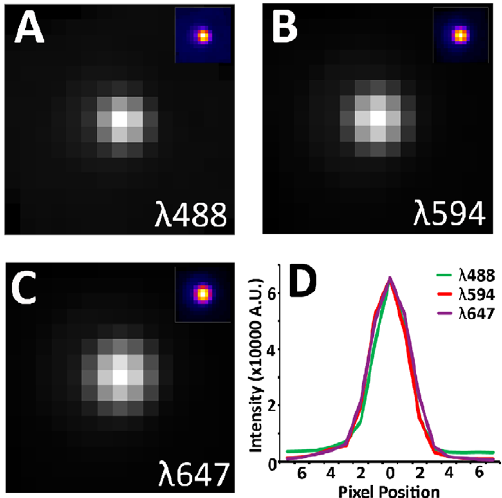
Figure 1. Empirically measure point spread functions (PSF). 110 nm Tetraspeck beads (Invitrogen) are suspended in ethanol. The solution is then applied to ultra-thin (70 nm) tissue arrays and let dry. The arrays are then mounted in mounting medium and imaged. Special care is made to ensure that no more than a single pixel per bead is saturated. Beads from multiple images across the entire field is registered and averaged to produce a single PSF. (A) PSF at 488 nm. Average of 268 beads. (B) PSF at 594 nm. Average of 282 beads. (C) PSF at 647 nm. Average of 335 beads. (d) Cross-sectional plot of each PSF. Note that the width of the PSF increases slightly with increased